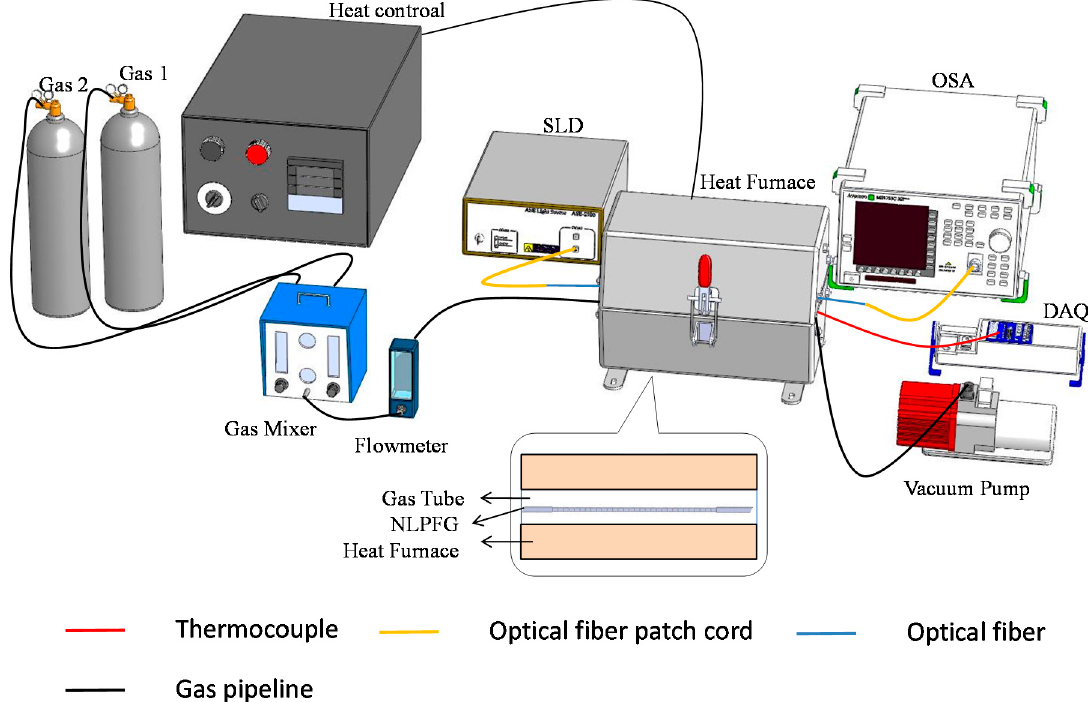
Figure 3. Experimental setup for CO 2 gas sensing.